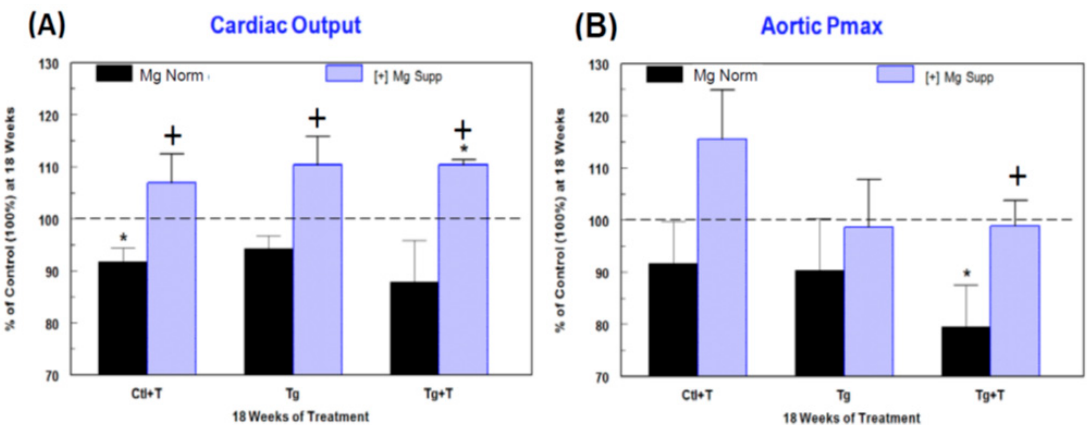
Figure 6. Effects of HIV-1 expression ± cART (T) on ( A ) cardiac output and ( B ) aortic pressure maximum of Mg-normal and Mg-supplemented rats after 18 weeks. These parameters were monitored by echocardiography. Values are means ± SE = 5 rats/group. * p < 0.05 vs. Ctl (100%); + p < 0.05 vs. Mg-normal counterparts.